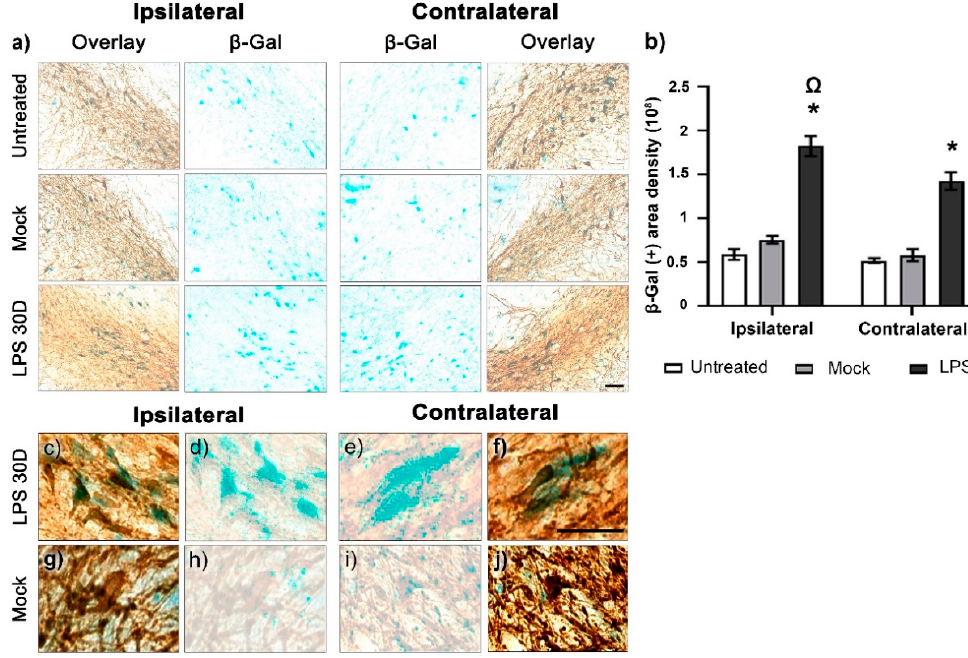
Figure 7. LPS induces senescence in dopaminergic neurons of the SNpc. ( a ) Representative micro- graphs of the SNpc with β -Gal staining and TH immunohistochemistry. ( b ) The Area density of β -Gal staining was measured by ImageJ software v.1.46r (National Institutes of Health, Bethesda, MD). The values are the mean ± SEM from three anatomical levels, n = 3 independent rats in each experimental condition. The asterisk (*) compares the LPS groups with the Mock group on both sides. The omega symbol ( Ω ) compares the ipsilateral SNpc with the contralateral side. One-way ANOVA and post hoc Tukey test, p < 0.05. Representative amplified photomicrographs show the collocation of β -Gal counterstaining with TH (+) cells in the SNpc of the LPS group ( c – f ) but not of the Mock group ( g – j ). The scale bars = 50 µ m are for all